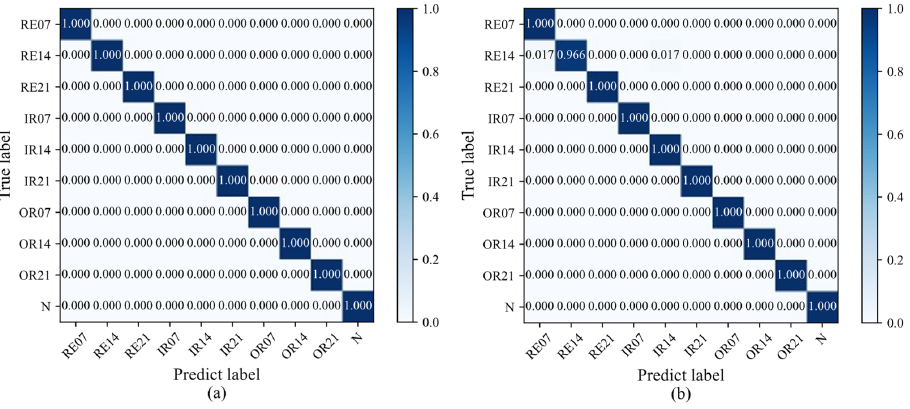
Figure 10. Confusion matrix of ( a ) the best diagnosis result and ( b ) the worst diagnosis result for Dataset A produced by the multi ‐ information fusion ViT model. Dataset A produced by the multi-information fusion ViT